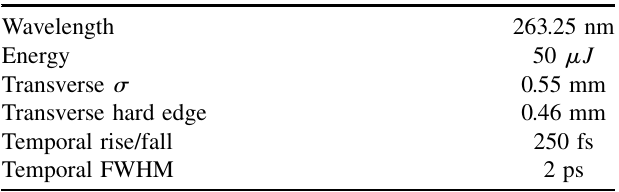
TABLE II. Photocathode drive-laser parameters.